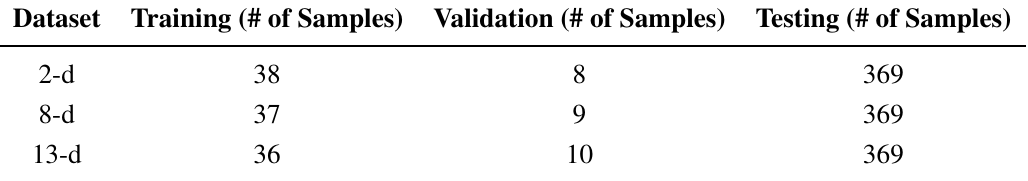
Table 1. Size of training ,validation and testing